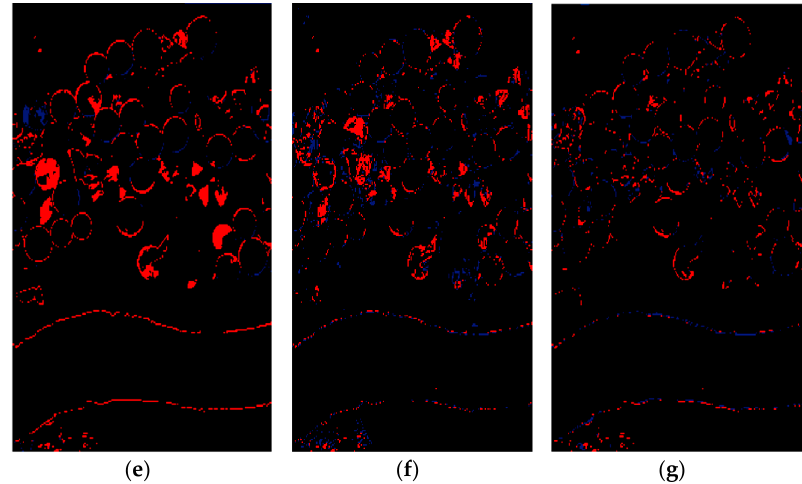
Figure 19. The error in change detection maps obtained by different methods for the Hyperspectral-Farmland dataset. ( a ) CVA-SVM, ( b ) MAD-SVM, ( c ) PCA-SVM, ( d ) IR-MAD -SVM, ( e ) SFA-SVM, ( f ) 3D-CNN, and ( g ) Proposed Method. Black, red, and blue colors indicate TP and TN, FN, and FP pixels, respectively.